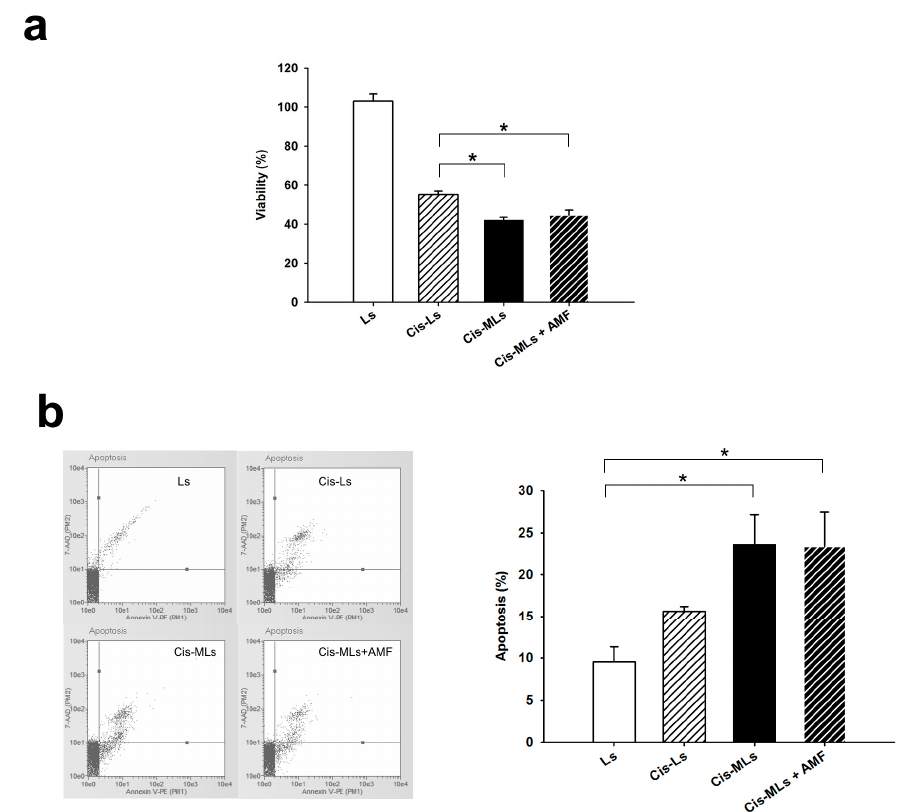
Figure 8. ( a ) Cell viability at 72 h post-treatment with liposomes only (Ls, control), cisplatin-loaded liposomes (Cis-Ls), cisplatin-loaded magnetic liposomes (Cis-MLs), and Cis-MLs plus magnetic hyperthermia treatment with an alternating current magnetic field (AMF) (Cis-MLs + AFM); ( b ) Percentage of apoptotic cells at 72 h after treatment with liposomes only (Ls, control), cisplatin-loaded liposomes (Cis-Ls), cisplatin-loaded magnetic liposomes (Cis-MLs), and Cis-MLs plus magnetic hyperthermia treatment (Cis-MLS + AFM). Values are expressed as the mean ± SEM of three individual experiments. ( * ) Indicates a significant difference ( p < 0.05 ) between the groups .